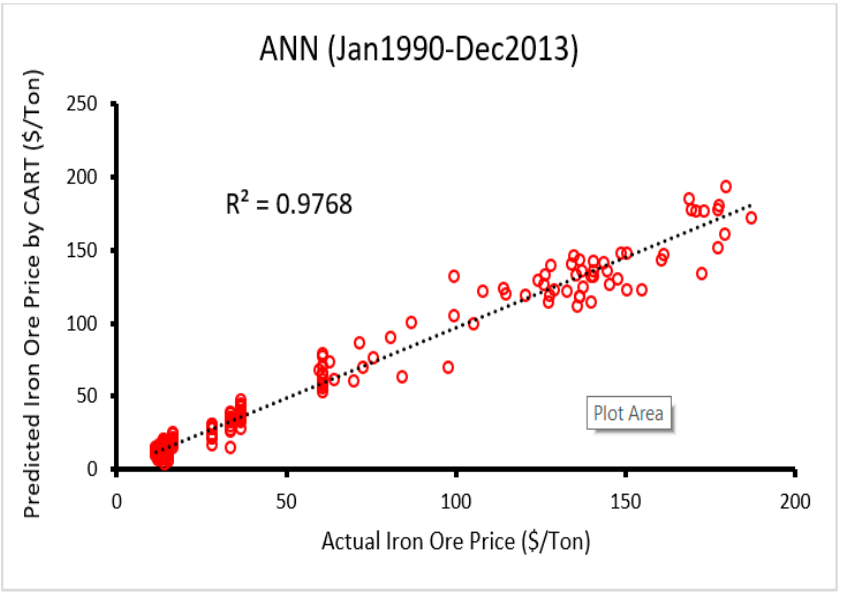
Figure 9. Scatter plot of the predicted vs. actual iron ore price developing artificial neural network (ANN) model.